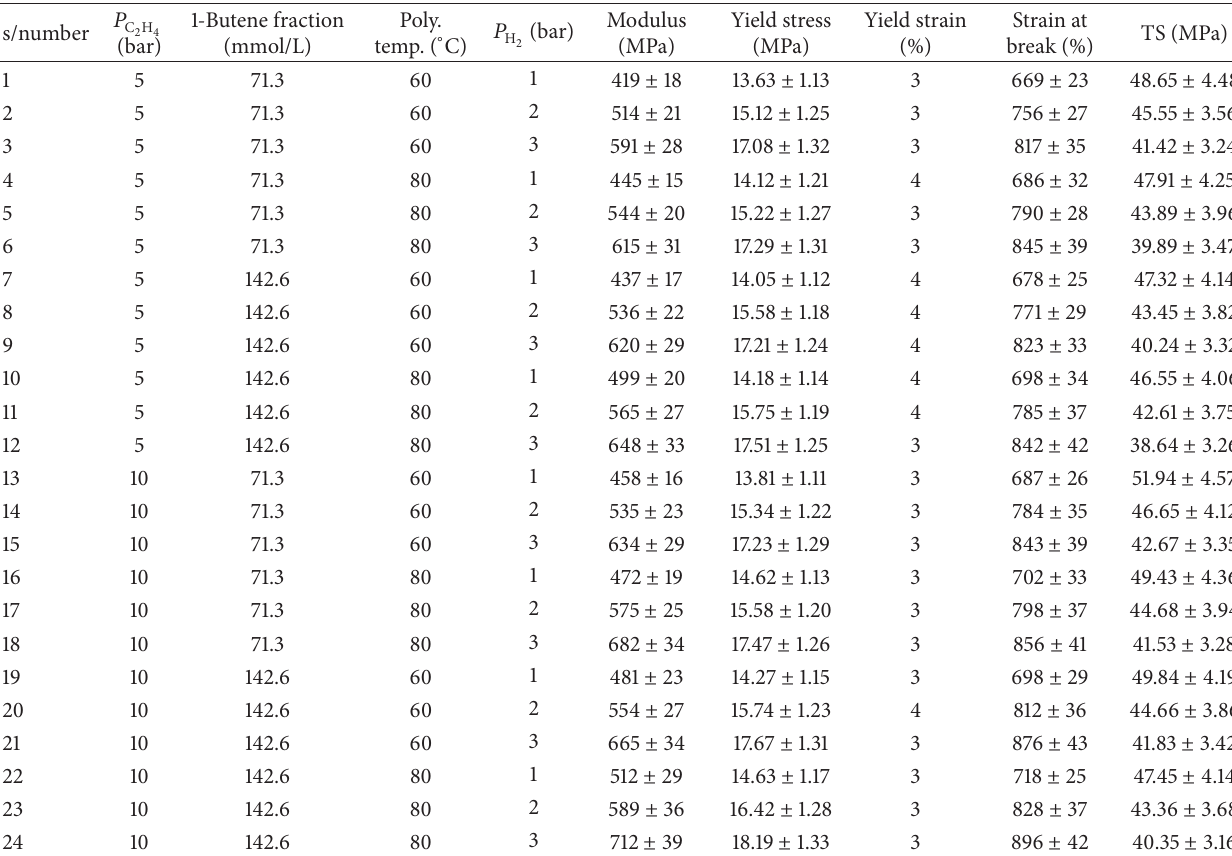
Table 4: Mechanical properties of ethylene/1-butene copolymer (polymerization time: 30